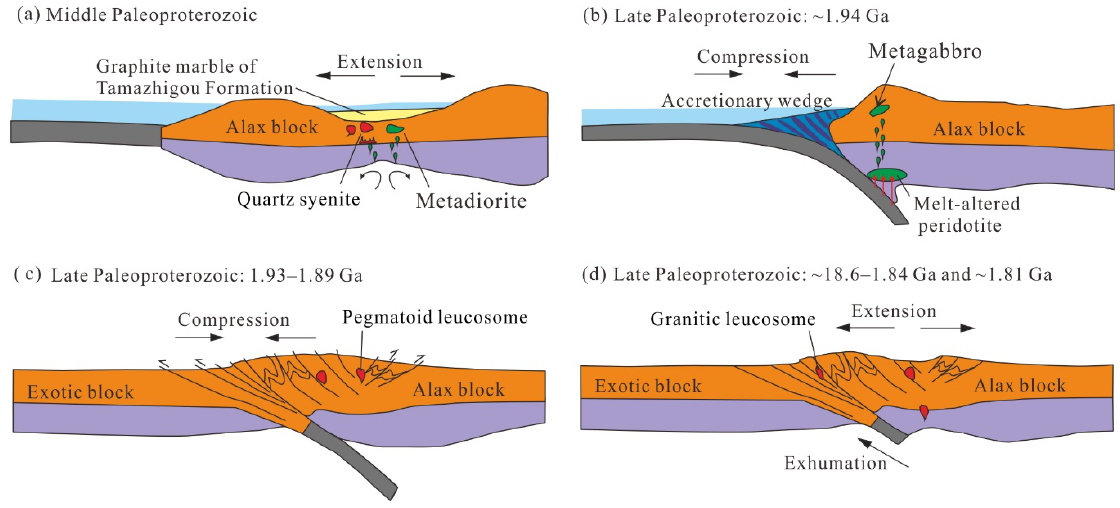
Figure 14. Tectonic evolution of the southwest margin of the NCC in four stages in middle to late Paleoproterozoic. ( a ) intraplate extensional setting in the middle Paleoproterozoic; ( b ) convergent setting at ~1.94 Ga; ( c ) continental subduction at 1.93–1.89 Ga; ( d ) exhumation at ~1.86–1.84 Ga and ~1.81